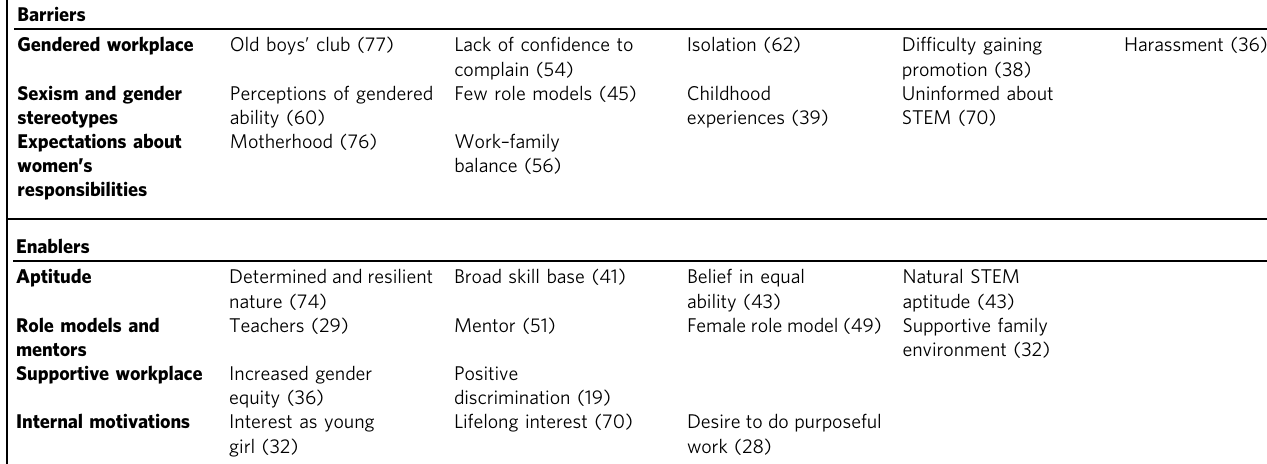
Table 1 Categorisation of factors in fl uencing women ’ s STEM career paths (number of references contributing to each sub-category across